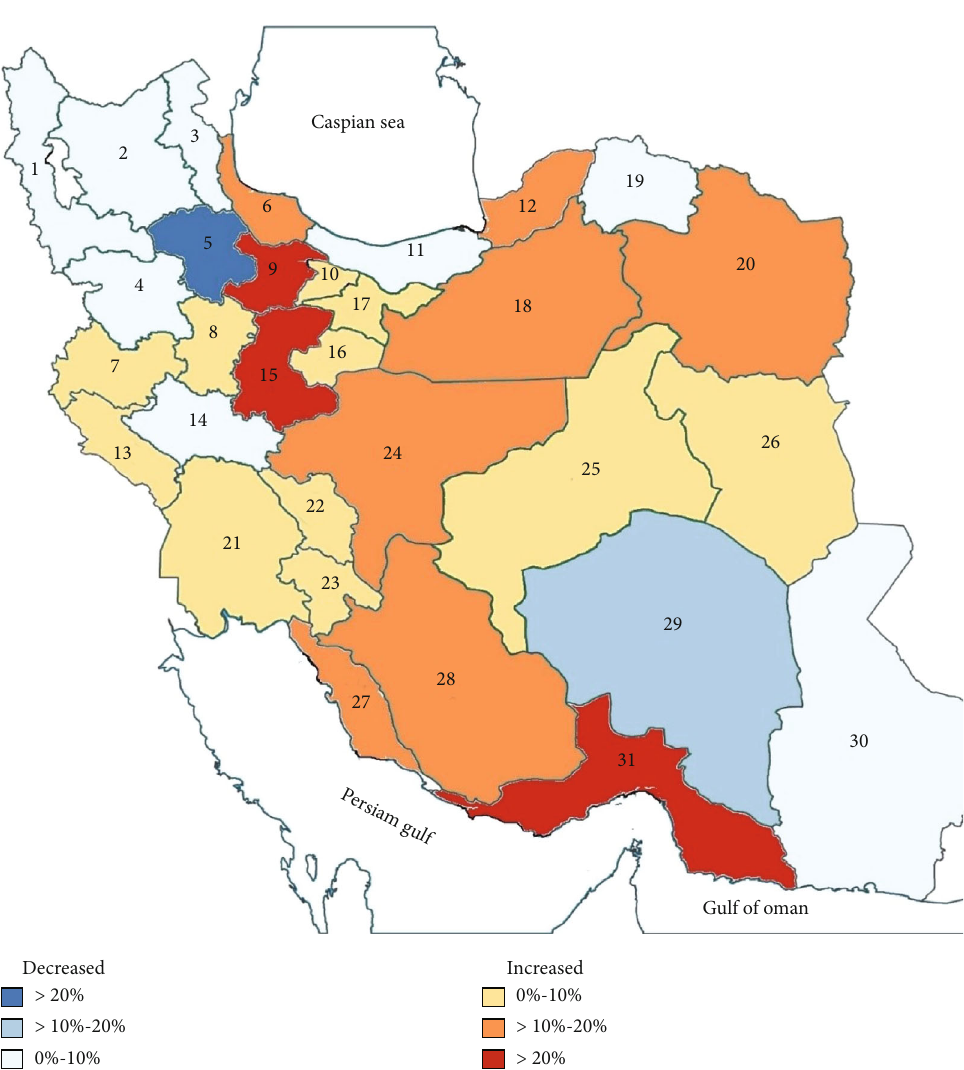
Figure 1: Relative changes in cancer age-standardized rate for both sexes from 2000 to 2016 in provinces of Iran. 1 indicates West Azarbayjan, 2: East Azarbayjan, 3: Ardabil, 4: Kurdistan, 5: Zanjan, 6: Gilan, 7: Kermanshah, 8: Hamadan, 9: Qazvin, 10: Alborz, 11: Mazandaran, 12: